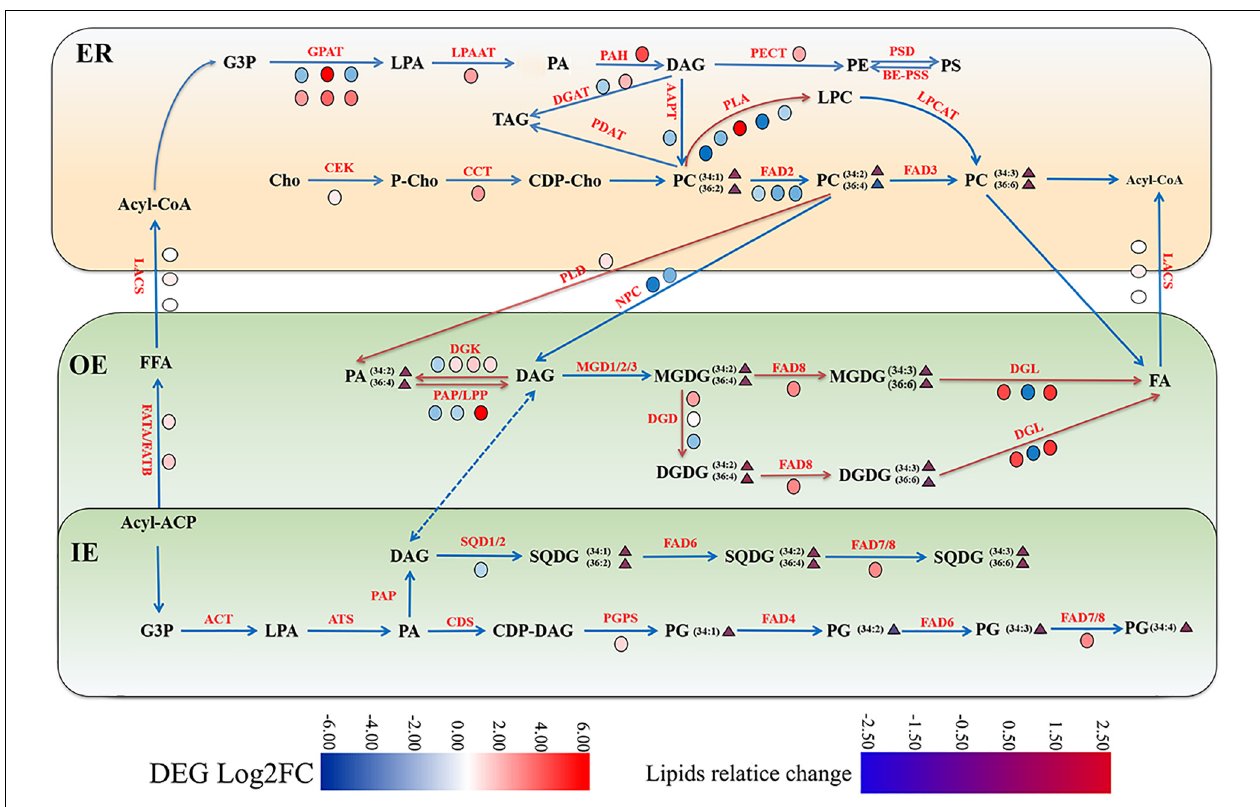
FIGURE 7 | Gene-metabolite network illustrating membrane lipid metabolism in maize under cold stress. The glycerolipids synthesis pathways were depicted and the involved genes and lipid metabolites were symbolized. The relative change of lipid molecular species and the relative expression levels of selected genes were marked as heatmap icons. The color scale is provided. Red color indicates higher expression level, and green color indicates lower expression level. The red arrows represent activated steps by cold. ER, endoplasmic reticulum; OE, outer envelope. IE, inner